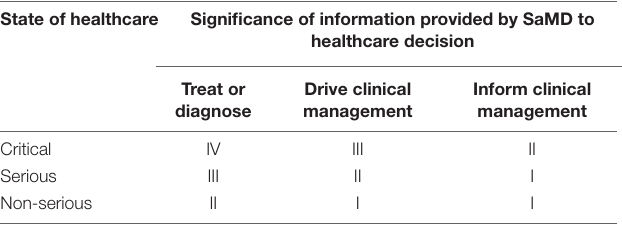
TABLE 1 | Internationally recognized SaMD risk classification according to IMDRF. State of healthcare Significance of information provided by SaMD to healthcare